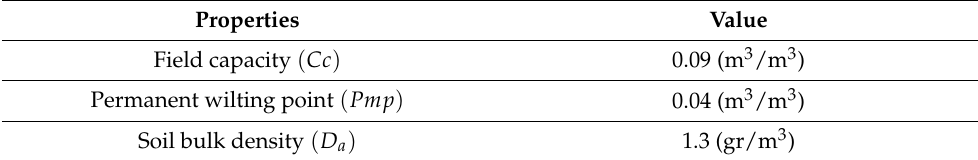
Table 1. Soil properties.